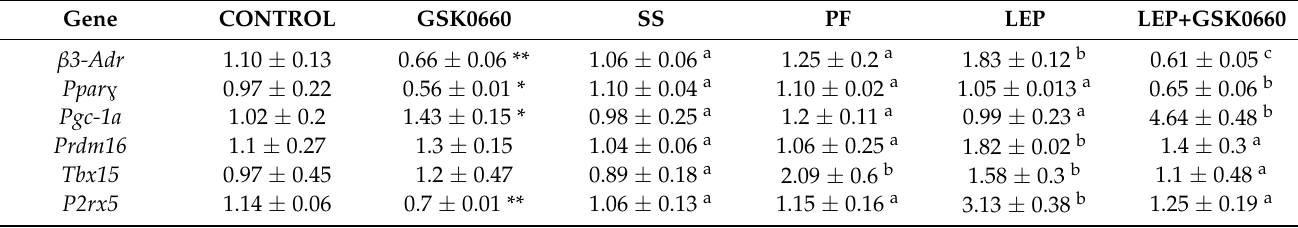
Table 3. Gene expression of β 3-Adr, Ppar G , Pgc-1a , Prdm16, Tbx15 , and P2rx5 in